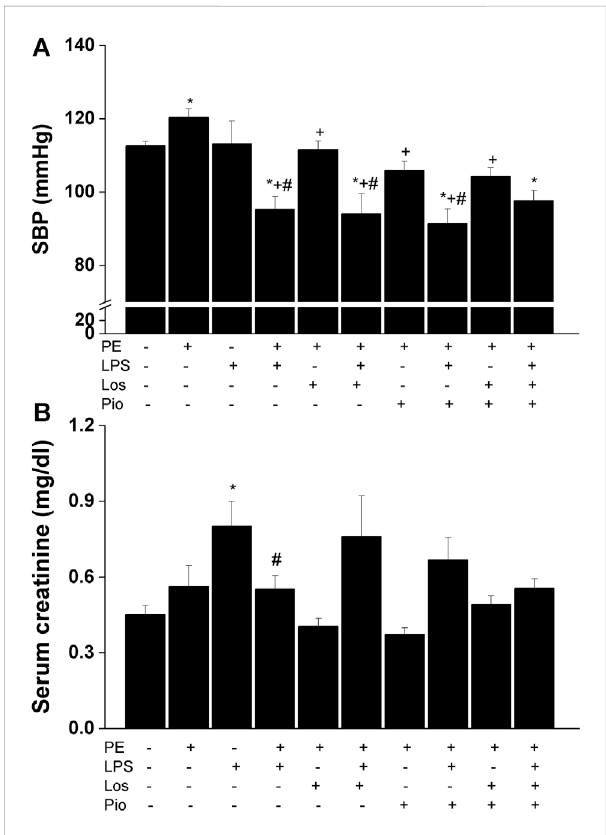
FIGURE 3 Effect of gestational losartan and/or pioglitazone therapy on SBP measurements (panel A ) and serum creatinine (panel B ) in male offspringofPEorPE/LPSdams.Valuesareexpressedasmeans±S.E.M of 7-8 measurements. The One-way ANOVA followed by the Tukey ’ s post hoc was utilized to measure statistical signi fi cance. * p < 0.05 vs. “ Control ” , + p < 0.05 vs. “ PE ” and # p < 0.05 vs. “ LPS ”